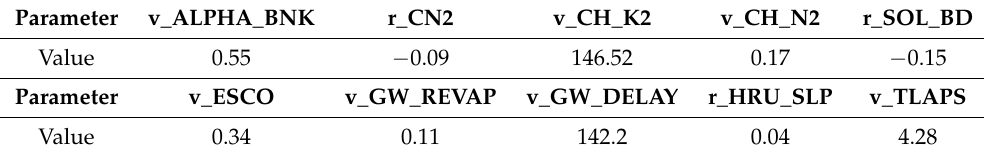
Table 8. Values of the fixed parameter set used for each precipitation input.